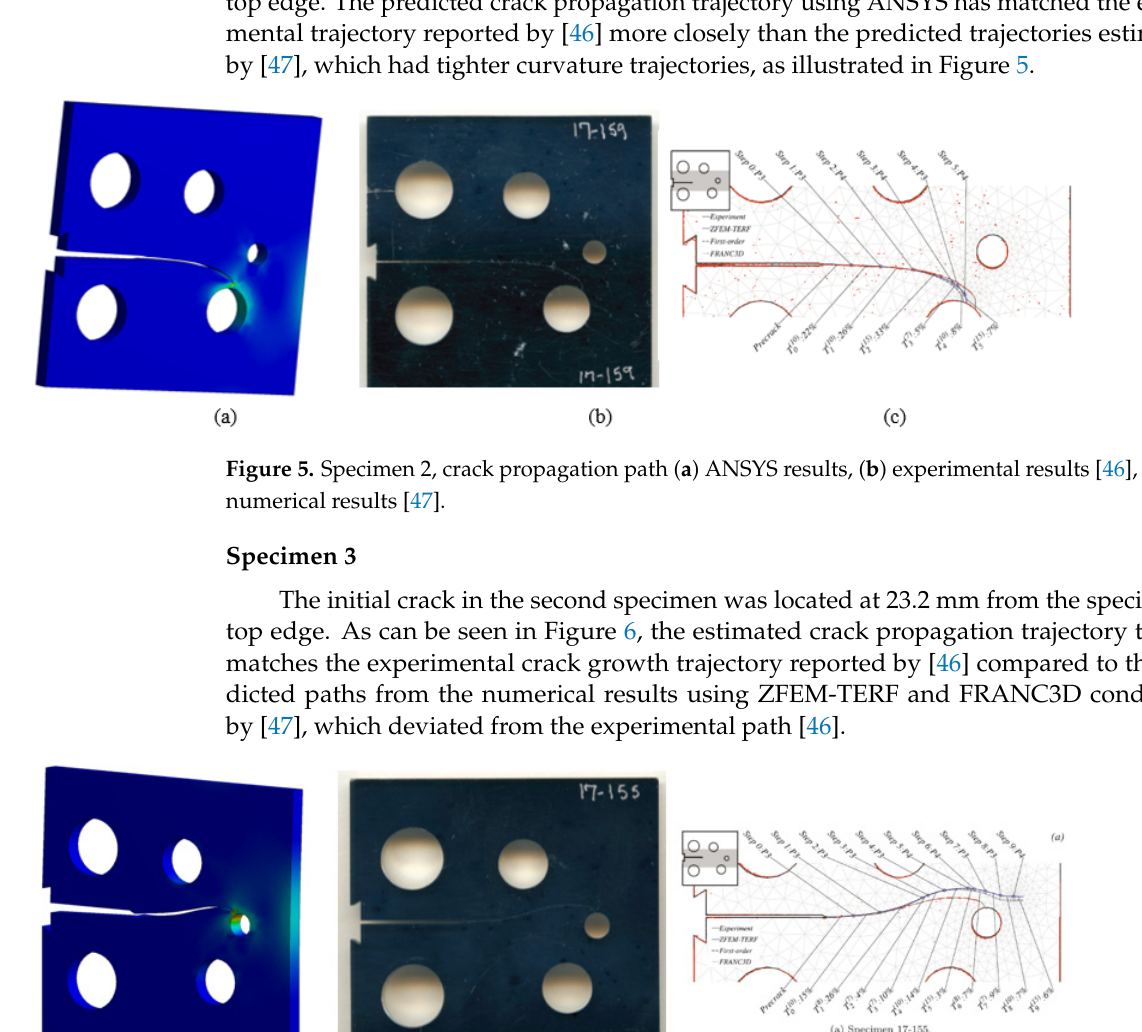
Figure 4. Specimen 1, crack propagation path ( a ) ANSYS results, ( b ) experimental results [46], and ( c ) numerical results [47].